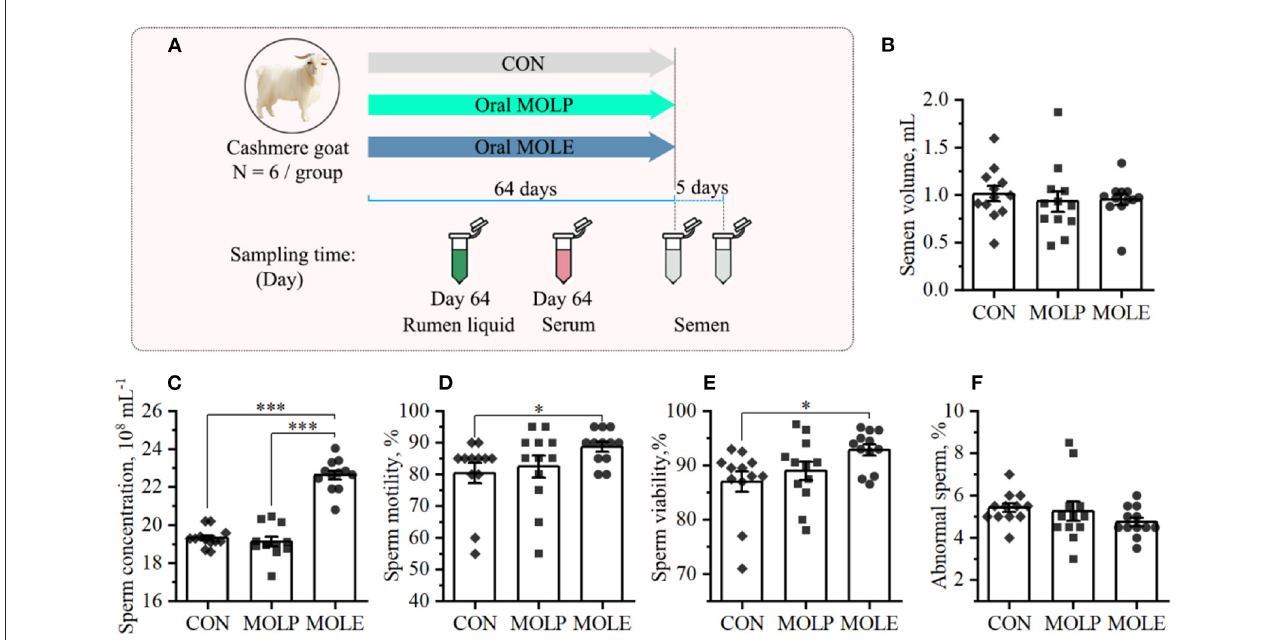
FIGURE1 Effects of MOLP and MOLE on semen quality. (A) Schematic of study design. (B) Semen volume. (C) Sperm concentration. (D) Sperm motility. (E) Sperm viability. (F) Abnormal sperm. Data were expressed as the mean ± SEM. * P < 0.05; *** P < 0.001. CON, Control; MOLP, Moringa oleifera leaf powder; MOLE, Moringa oleifera leaf ethanolic